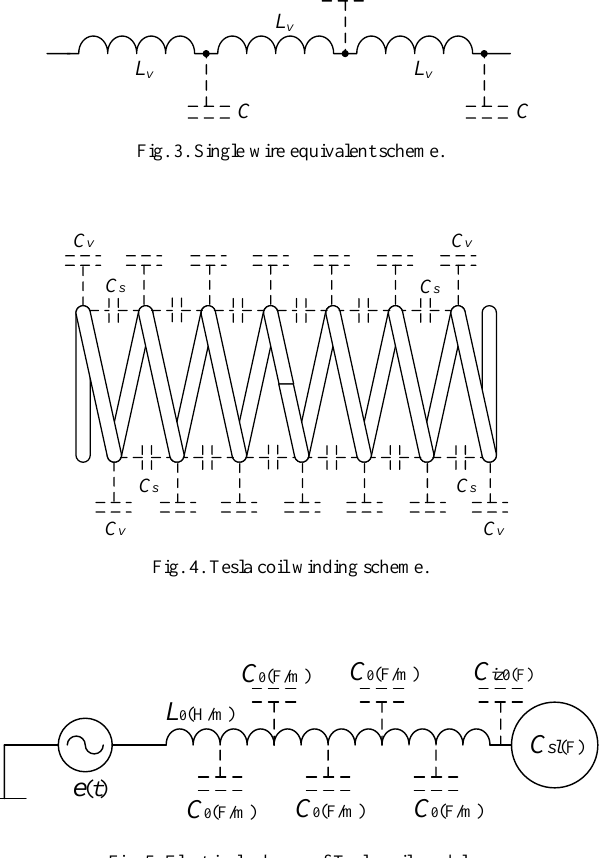
Fig. 6. Conductive body (a) and its virtual ground VG